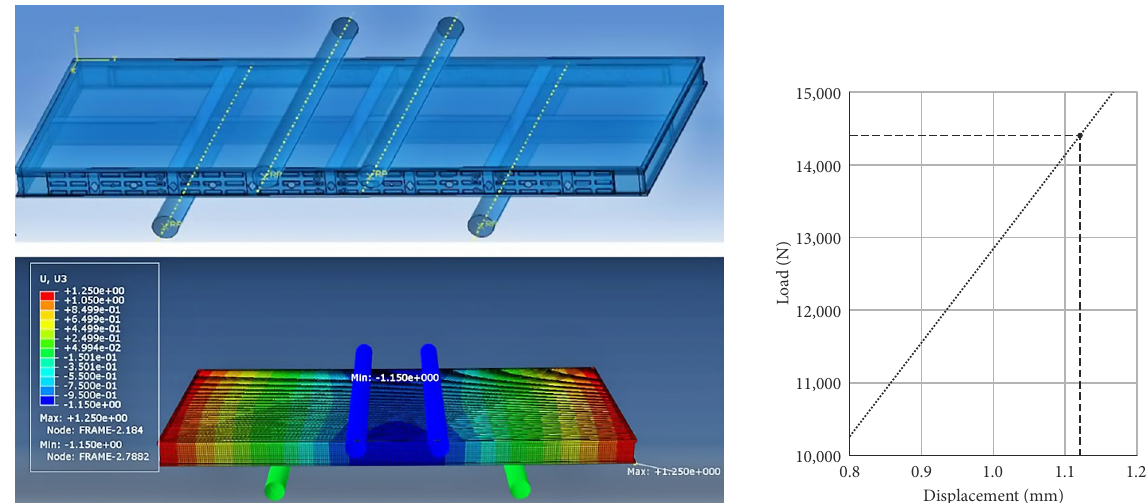
Figure 7. Structural analysis of prototype (deflection)